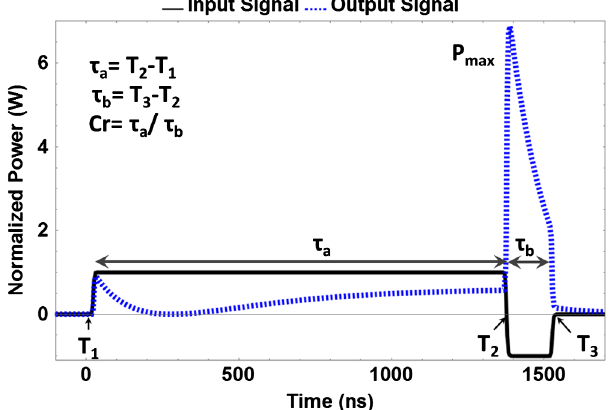
FIG. 8. Numerically derived output power (dashed:blue) using the convolution of an RLC resonator model and standard input pulse (black) for passive pulse compression cavities.